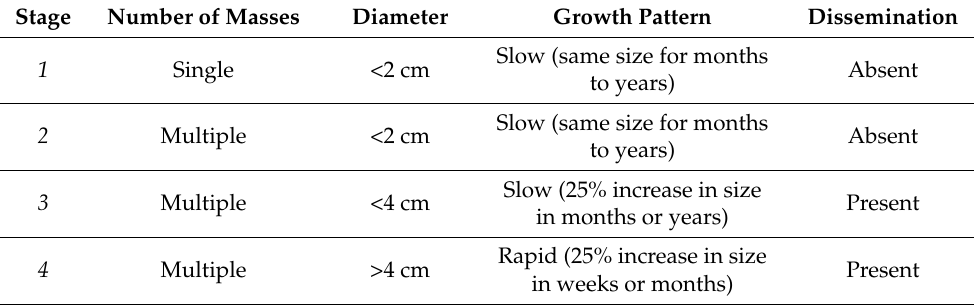
Table 1. Clinical stages of equine malignant